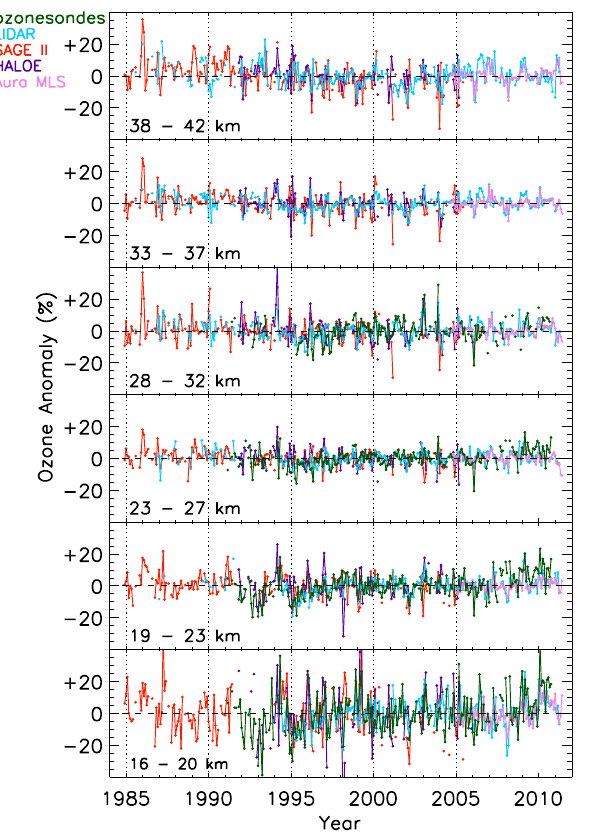
Fig. 4. Time series of ozone anomalies at OHP estimated from lidar, ozonesondes, SAGE II, HALOE and Aura MLS ozone measure- ments at specific altitude bands. The data are resolved on a 1km vertical grid.